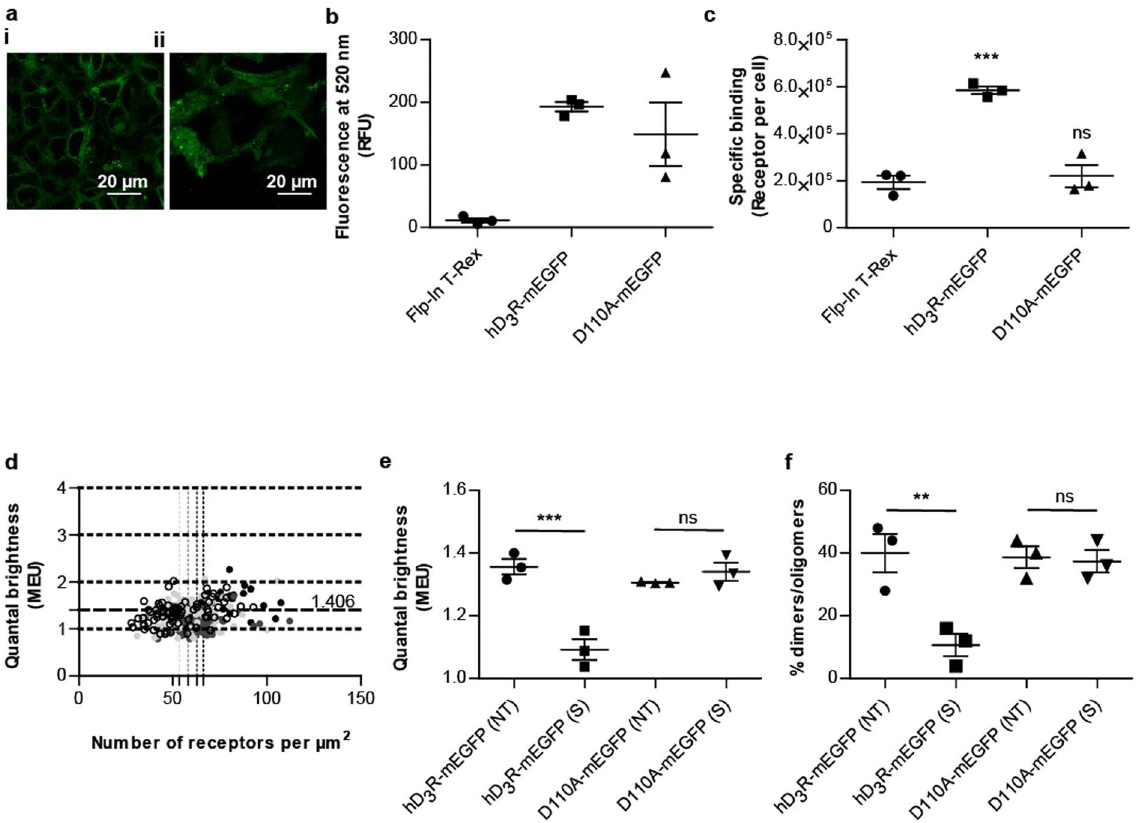
Figure 8. Treatment with spiperone does not alter the quaternary organization of hD 3 R-Asp 110 Ala. hD 3 R- Asp 110 Ala-mEGFP was expressed constitutively in Flp-In T-REx 293 cells. Confocal images were collected across the midsection ( a ( i )) and from the basolateral membrane ( a ( ii )) of cells. Scale bar = 20 μ m. ( b ) Fluorescence intensity corresponding to mEGFP was measured in non-transfected ( circle ), hD 3 R-mEGFP- ( square ) or hD 3 R-Asp 110 Ala -mEGFP ( triangle ) expressing Flp-In T-REx 293 cells. Data from n = 3 experiments, with the average value from each experiment shown, error bars represent ± S.E.M. ( c ) Specific binding of [ 3 H] spiperone (5 nM) was assessed in either non-transfected ( circle ), hD 3 R-mEGFP ( square ) or hD 3 R-Asp 110 Ala -mEGFP ( triangle ) expressing Flp-In T-REx 293 cells. Data from n = 3 experiments with the average value from each experiment shown, error bars represent ± S.E.M. ns = not significant; *** p < 0.001 when compared to non-transfected Flp-In T-REx 293 cells. ( d ) QB MEU were assessed in individual RoI and plotted against the number of receptors per µ m 2 at the cell surface. Black circles , untreated hD 3 R-mEGFP expressing cells; Dark grey circles , spiperone treated hD 3 R-mEGFP expressing cells; Light grey circles , untreated hD 3 R-Asp 110 Ala-mEGFP expressing cells; Open circles , spiperone treated hD 3 R-Asp 110 Ala -mEGFP expressing cells. ( e ) Quaternary arrangement of hD 3 R-mEGFP or hD 3 R-Asp 110 Ala-mEGFP receptors expressed as QB MEU value in not treated cells ((NT) 1.36 ± 0.02 and 1.31 ± 0.03, respectively) and cells treated with spiperone ((S) 1.09 ± 0.03 and 1.34 ± 0.03, respectively). Combined data from n = 3 × 25 measurements, error bars represent ± S.E.M. ns = not significant; *** p < 0.001 when compared to the indicated sample. ( e ) Assessment of percentage of RoIs containing predominantly hD 3 R-mEGFP or hD 3 R-Asp 110 Ala -mEGFP dimers/oligomers in untreated ((NT) 40.0 ± 6.1% and 38.7 ± 3.5%, respectively) or treated with spiperone ((S) 10.7 ± 3.5% and 37.3 ± 3.5%, respectively). Combined data from n = 3 × 25 experiments, error bars represent ± S.E.M., ns = not significant; ** p < 0.01 when compared to the indicated